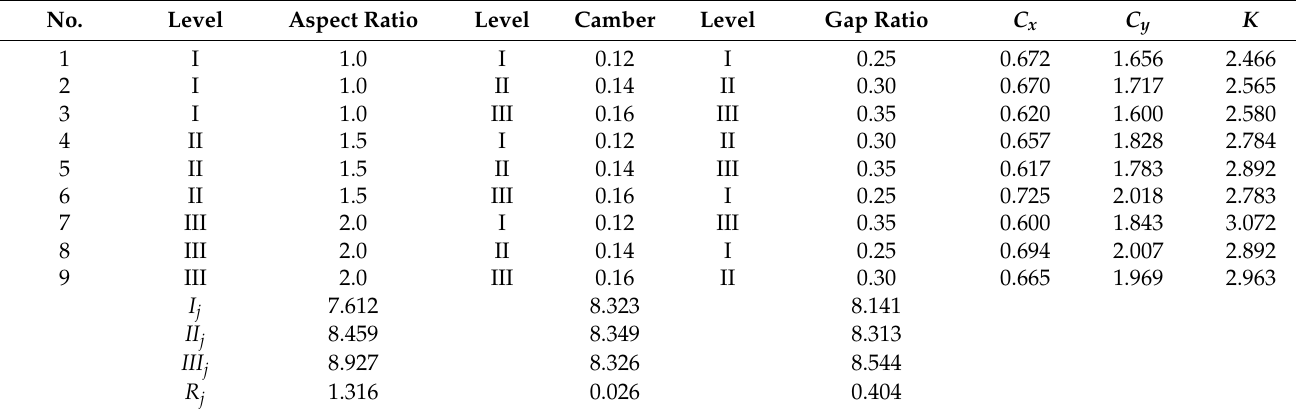
Table 6. Analysis of orthogonal testing at an angle of attack of 30 ◦ .